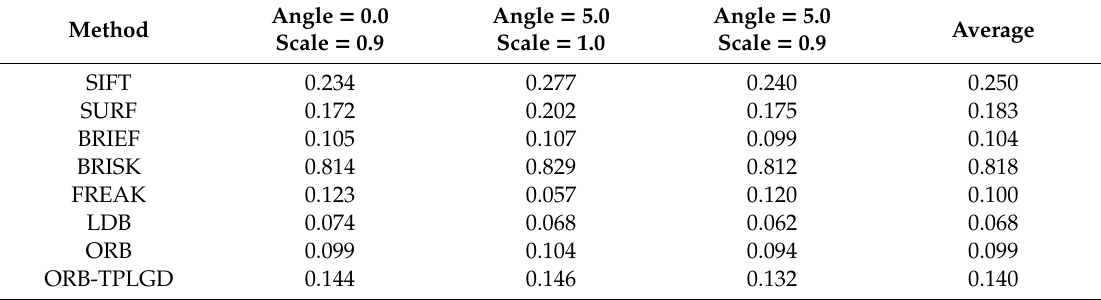
Table 10. Average matching time of test image matching algorithms for SAR dataset